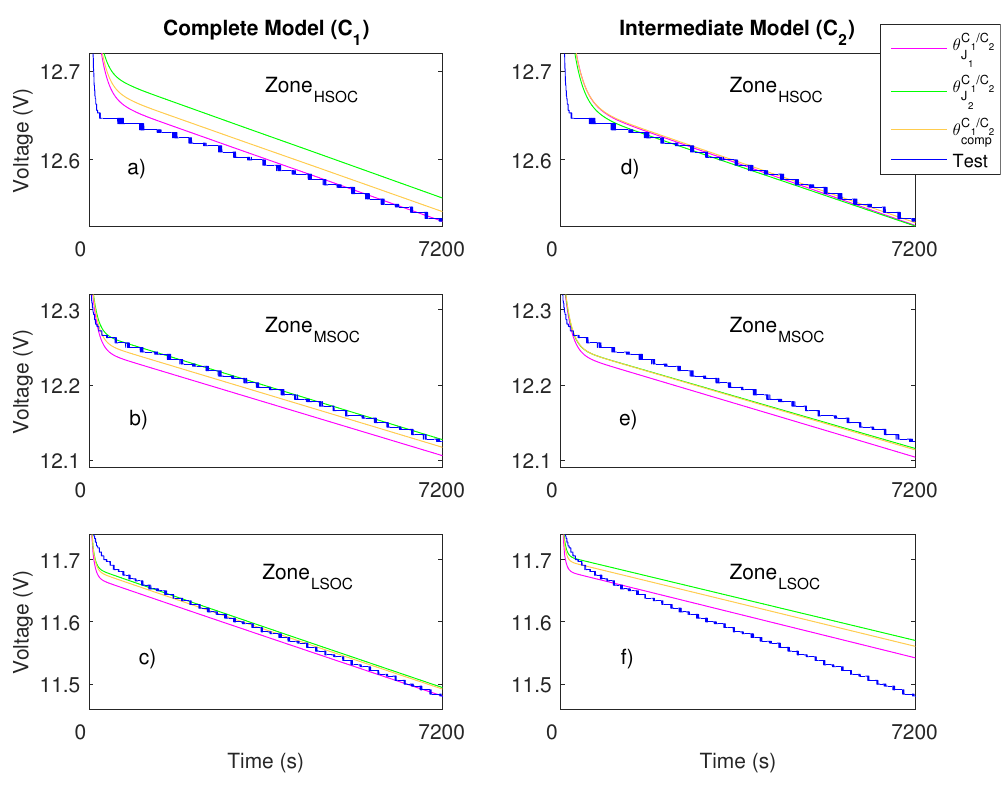
Figure 12. Discharge responses of the solutions highlighted in Figure 11 in different SOC zones, compared with the empirical data from test